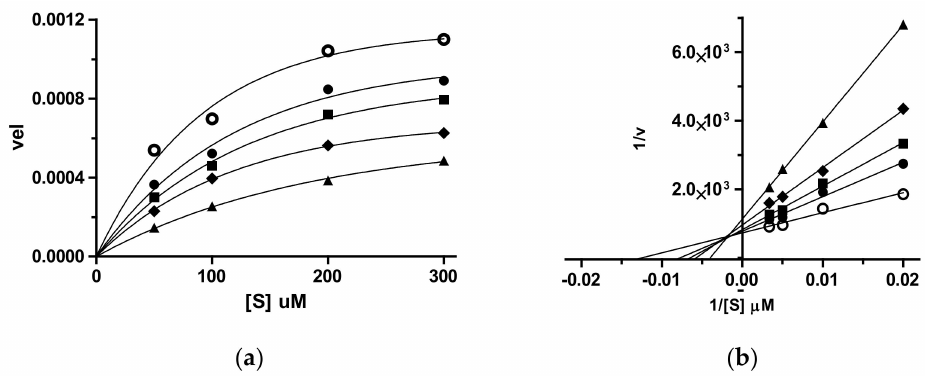
serum butyrylcholinesterase. 6 Previously reported [15].